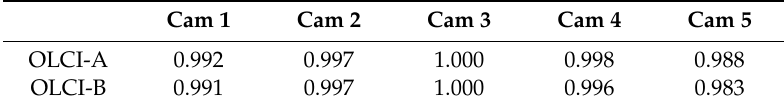
Table 3. Estimated flat-fielding adjustment coe ffi cients for OLCI-A and OLCI-B from